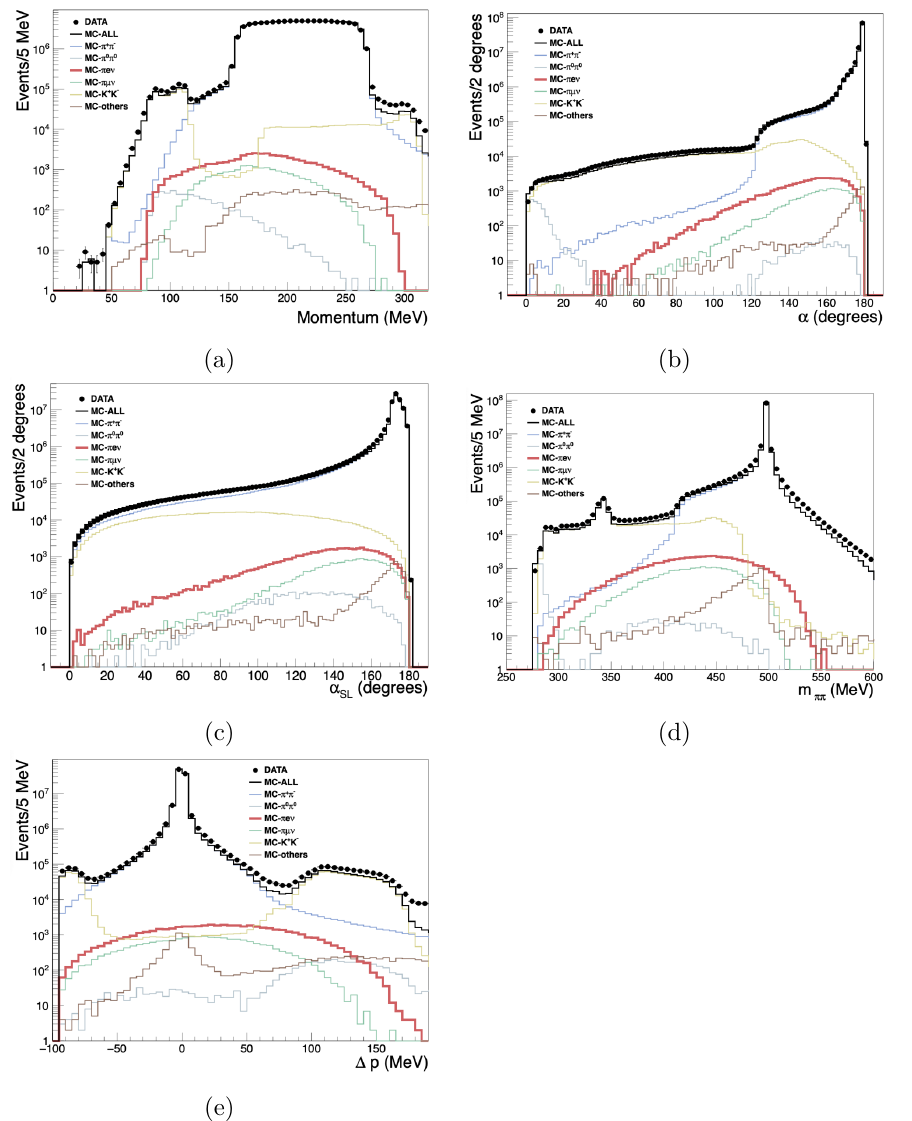
Figure 2 . Distributions of the variables used in the multivariate analysis for data and simulated events after preselection. From top left: track momenta ( p the K reference system ( α S